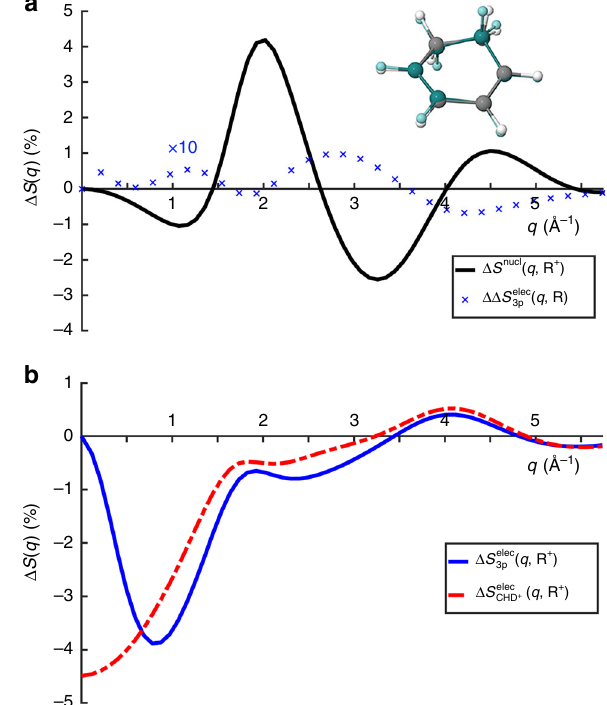
Fig. 3 Separation of nuclear and electronic contributions. Calculated fractional difference signals for the molecule CHD, assuming 100% excitation. a The nuclear contribution, Δ S nucl ð q ; R þ Þ , associated with the change in molecular geometry, R 0 ! R þ , upon excitation (in black) and the ð q ; R Þ ¼ Δ S elec ð q ; R þ Þ (cid:2) small difference due to electronic effects, ΔΔ S elec 3 p 3 p Δ S elec ð q ; R Þ shown at ×10 magni fi cation (in blue). The insert shows an 0 3 p overlap of the molecule in the excited state 3p geometry ( R + , gray) and the ground-state equilibrium geometry ( R 0 , dark green). b The electronic ð q ; R þ Þ , and for the molecular positive contribution for the 3p state, Δ S elec 3 p ð q ; R þ Þ . Note that only the result for the 3p ion, Δ S elec x state is shown CHD þ since the 3p x and 3p y states have nearly identical